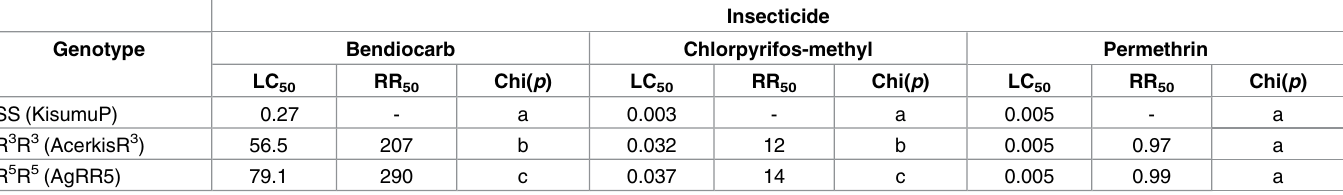
LC 50 : Concentration (mg.l -1 ) inducing 50% mortality. RR 50 : Resistance ratio = LC 50 (Strain) / LC 50 (KisumuP). Chi( p ): Comparison of the resistance levels conferred by the various genotypes; strains with different letters are significantly different. Underlying data can be found in DRYAD http://dx.doi.org/10.